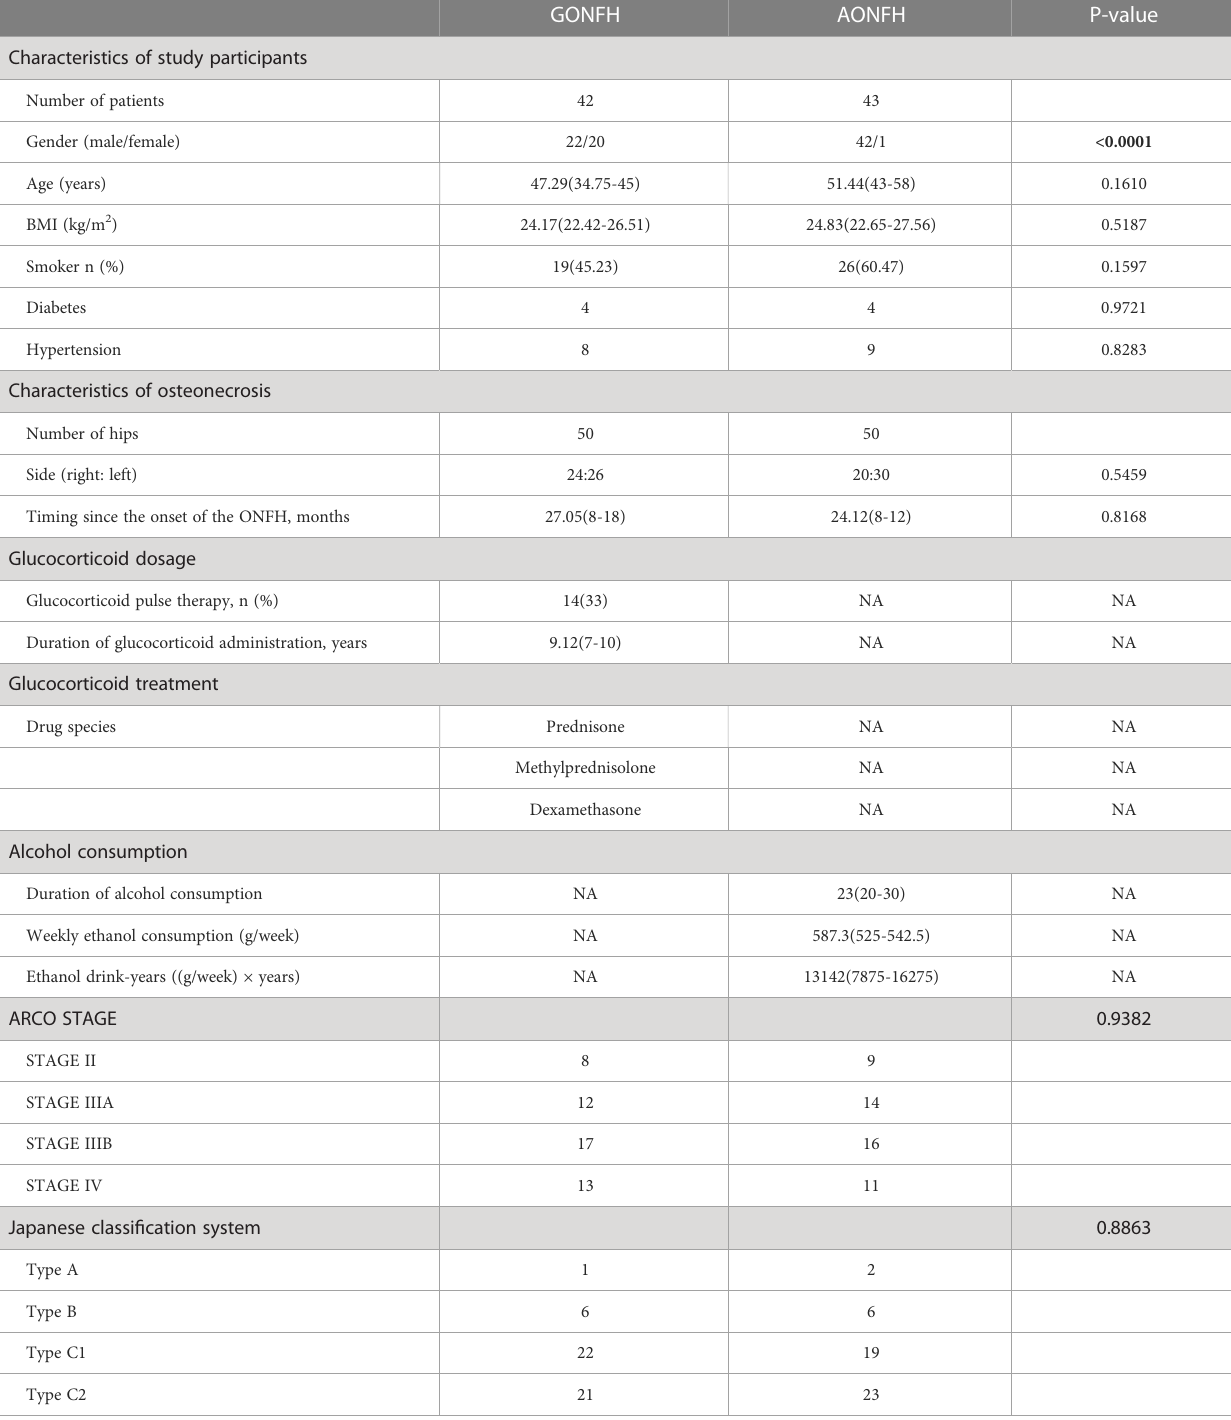
TABLE 1 Characteristics of the study